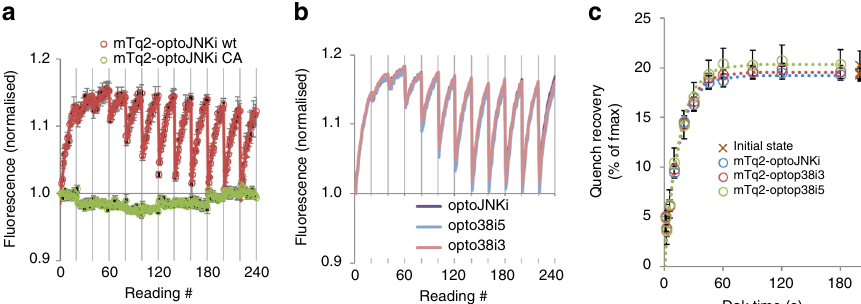
Fig. 5 Apparent activation rates, dark state relaxation rates and calculated sensitivities of selected Lov2-based actuators fused to mTurquoise2. a The optogenetic JNK inhibitor optoJNKi fused to mTq2 is evaluated using light-dark cycles as in Figs. 3 – 4 and compared with a C450A mutant version (green) that cannot form a cysteine adduct and therefore cannot cycle, as shown. Means ± SEM ( n = 3 wells) are plotted together with a series of exponential fi ts with a common activation constant (red line); b mTq2 fusions of optoJNKi, optop38i3 and optop38i5 are evaluated and the response curves show almost complete overlap. Raw averaged data ( n = 3 wells) is shown for each construct; c Best- fi t amplitudes (±S.E.) of exponentials fi tted to the data in b are plotted against preceding dark time; crosses plotted nominally at 200 s represent the amplitudes of the fi rst exponential which was not preceded by any light exposure. These data are fi tted to exponentials to derive the relaxation time in dark and maximal dequench (as % of initial signal) for each construct under the low illumination conditions used (14 µ mol m − 2 fl ash − 1 at ~4 Hz). Max dequench (as % of total), apparent activation rates, and relaxation time constants in dark for the data in b , c are shown in Table 1A. From these values, ED 50 , dequench limit (equivalent in each case to FRET ef fi ciency, assuming adduct has no effect) and sensitivity are derived. The C450A optoJNKi construct, which cannot form an adduct and therefore for which no activation or relaxation values could be derived, is also listed in the table. Source data are provided as a Source Data fi